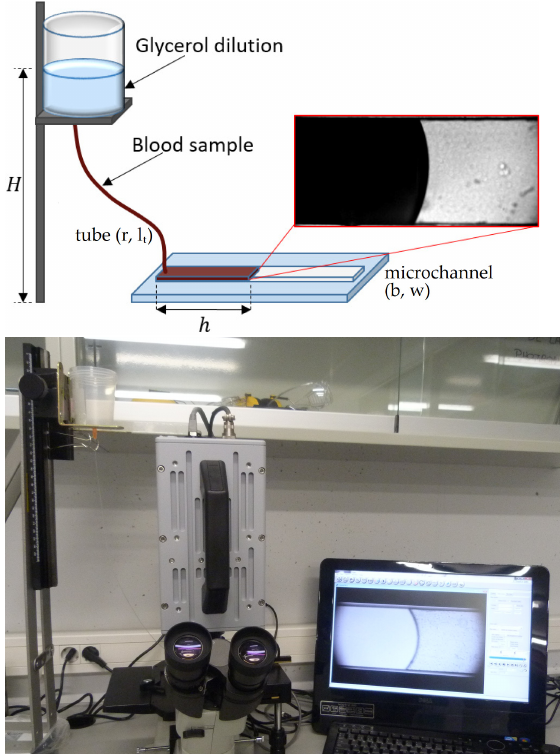
Figure 1. Experimental setup. On top, we present a schematic representation of the experimental set up, with a view of the blood–air interface inside the microchannel. The bottom picture shows a photograph of the experimental setup, where we can observe the reservoir, the high-speed camera, and the inverted